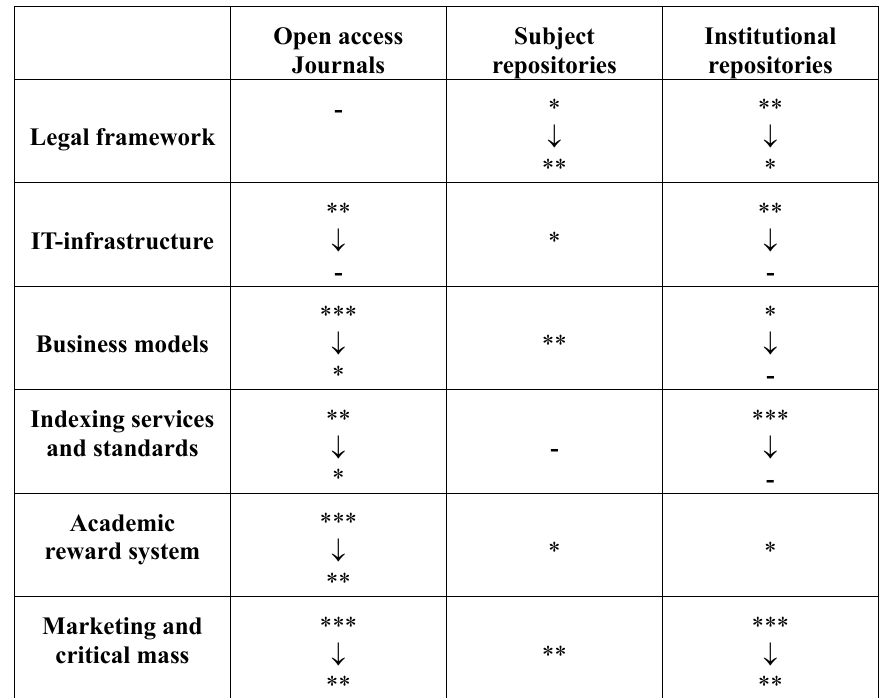
Table 2. The classification of different types of barriers for increased open access publishing and their relative importance, revisited